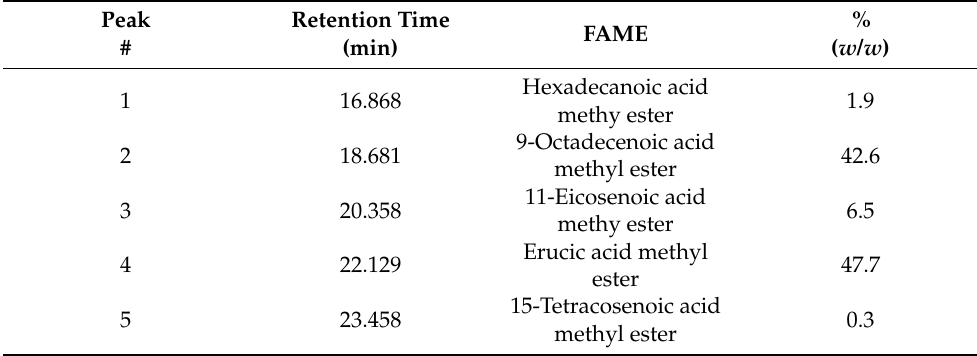
Table 3. FAME composition of biodiesel from E. sativa oil.